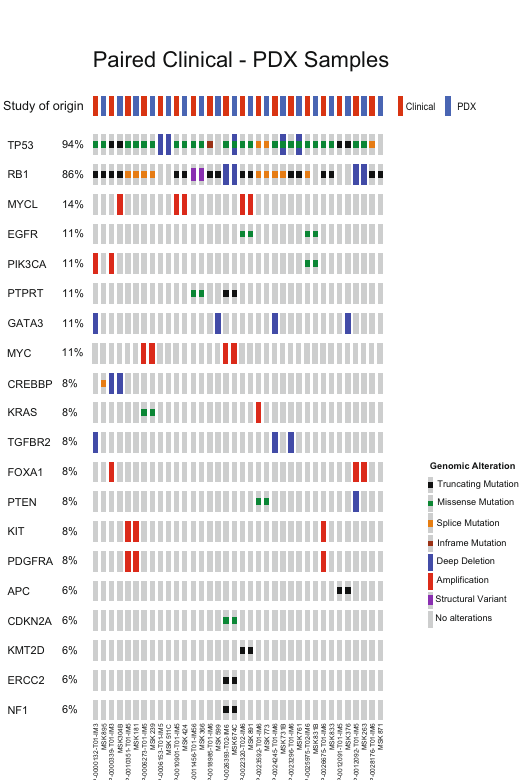
Fig. 2 Matched PDX and clinical SCLC sample analysis. Genomic landscape in SCLC ( a Clinical Samples, b patient-derived xenograft (PDX) Samples, c paired Clinical-PDX samples) samples representing putative driver alterations (i.e., excludes variants of unknown signi fi cance) in the top 20 most frequently altered genes as detected by MSK-IMPACT 20 targeted next-generation